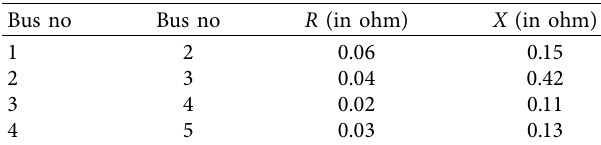
Figure 7: Illustration of demand side management scheme. Table 1: Line parameters for 5 bus test